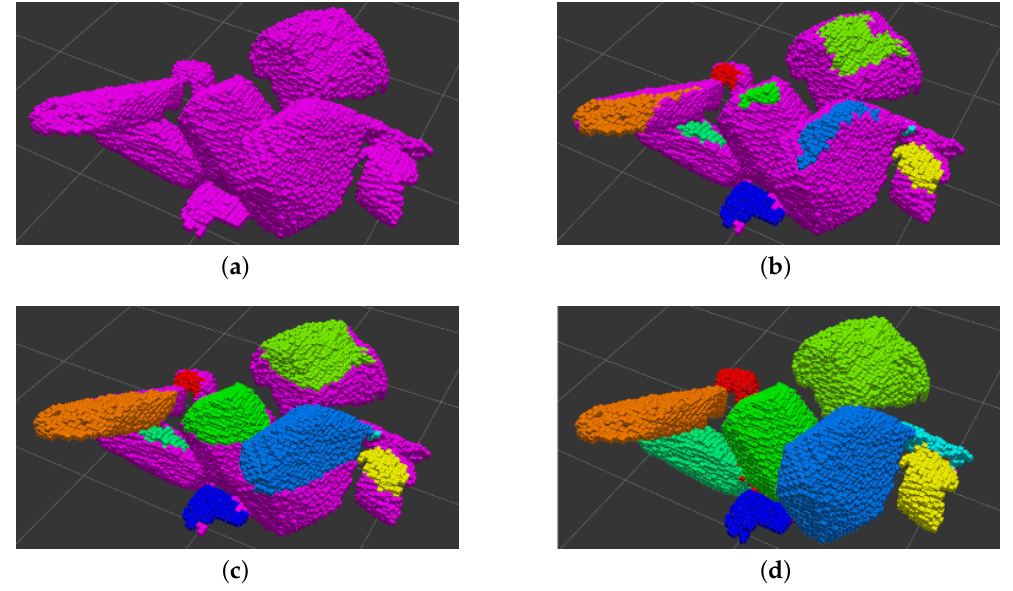
Figure 3. Example of rock segmentation using watershed on a point cloud. ( a ) Raw point cloud. ( b ) Result after initial labeling. ( c ) Intermediate result of the flooding process, where the initial labels are propagated from a higher level, up to an intermediate level. ( d ) Final result of flooding process, where all label are propagated until the lower